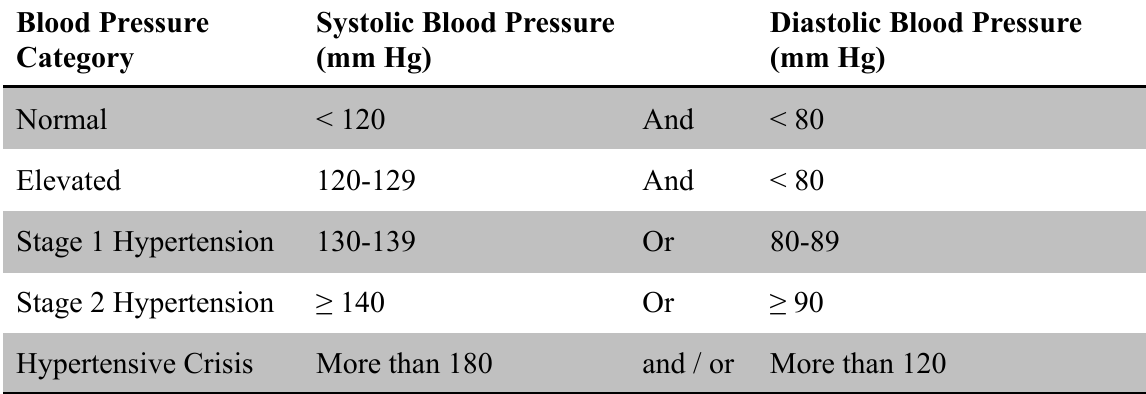
Table 1: American Heart Association classification of blood pressure